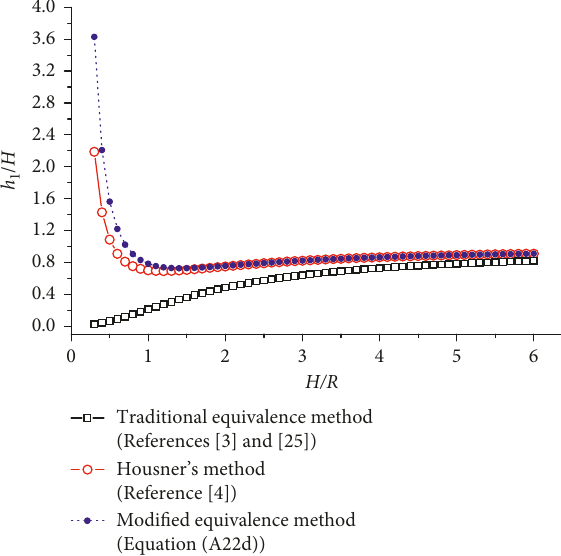
Figure 11: Position ratio h (cylindrical